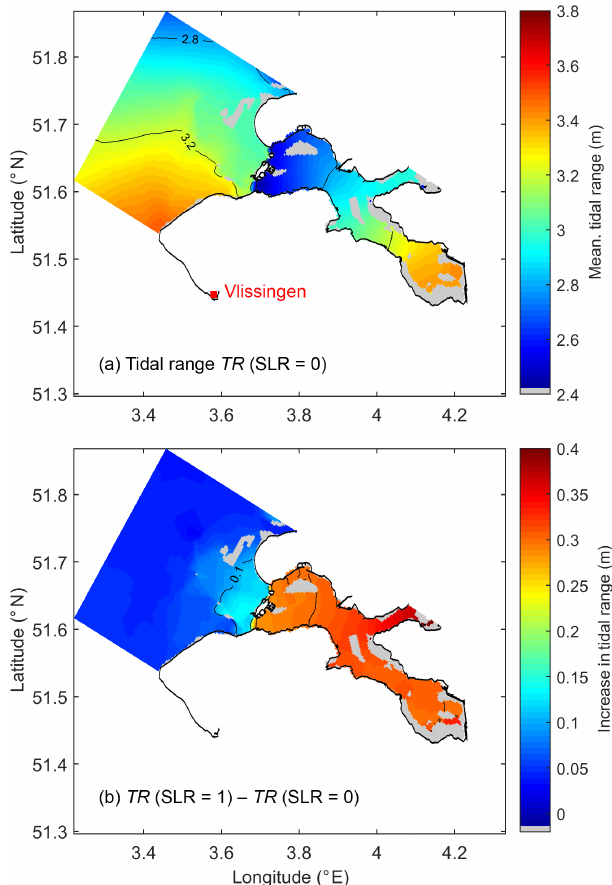
Figure 4. (a) Tidal range in the baseline scenario and (b) the dif- ference in tidal range between the 1m SLR and baseline scenarios. Tidal flats are shown in grey. Tidal range is calculated as the annual average of the difference between high and low water in every tidal